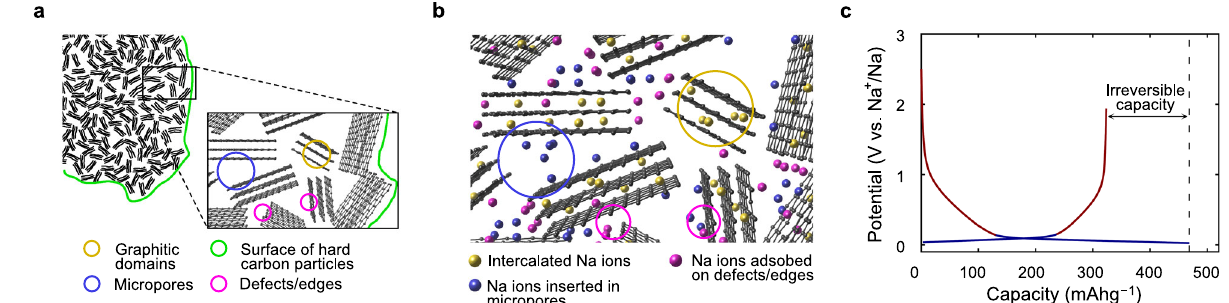
Fig. 1 Schematics related to the sodiation in HC. Schematic illustrations of a the structure of HC particle, b Na-ion storage in HC based on the house of cards model, and c typical charge – discharge curve with HC anode. The colors of Na ions in ( b ) are corresponding to the sodiation sites in ( a ).